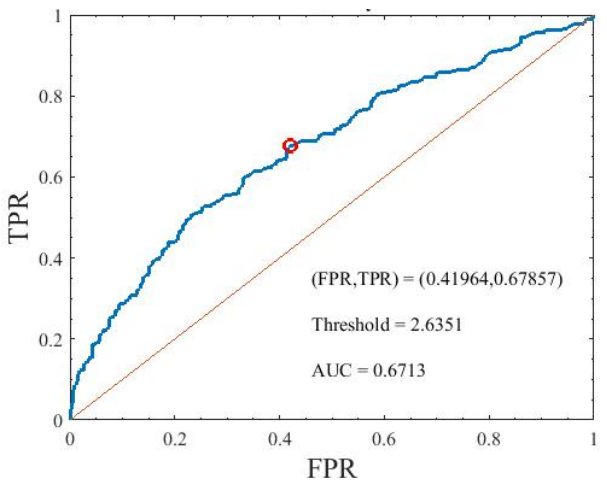
Figure 11. Area under the curve of the DAN factor used to identify the participants with diabetes mellitus. TPR is true positive rate and FPR is false positive